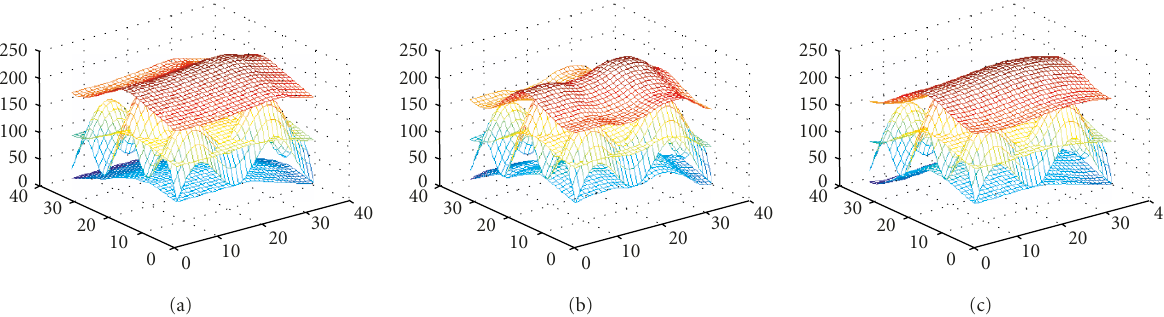
Figure 11: Mesh plots of 32 × 32-pixel regions taken from the 256 × 256-pixel STI and its UE, LE, and ME employing (a) FABEMD Type-4 OSFW (4.298072 seconds), (b) FABEMD Type-1 OSFW (3.717336 seconds), (c) BEMD RBF-TPS (193.124406